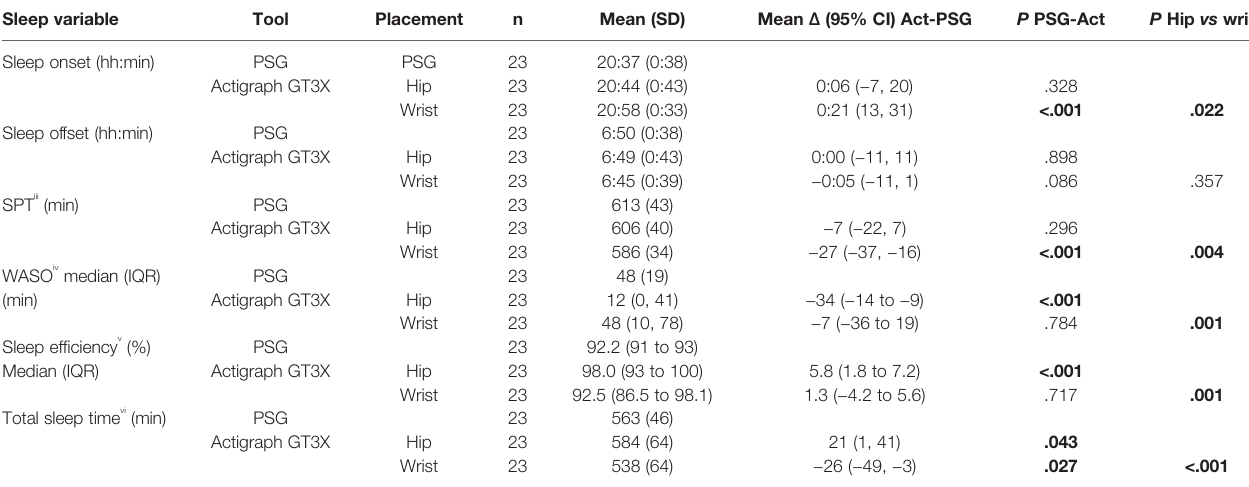
TABLE 3 | Comparison of Actigraph GT3X measured sleep outcomes to PSG and comparison of wrist and hip positioned devices. Sleep variable Tool Placement n Mean (SD) Mean Δ (95% CI) Act-PSG Sleep onset (hh:min)